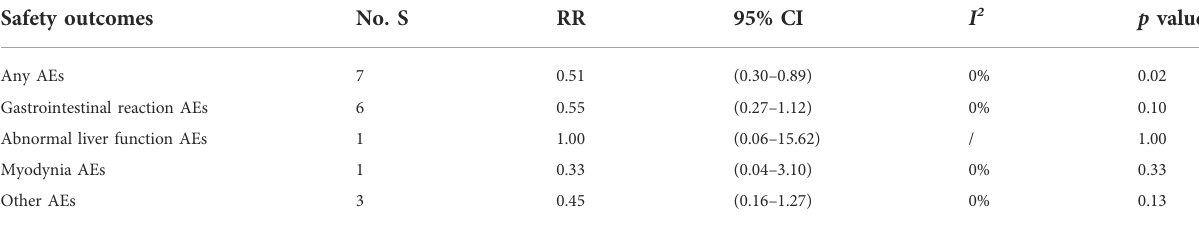
TABLE 3 Subgroup analysis of the main safety outcomes of ZBT + CT vs. CT. Safety